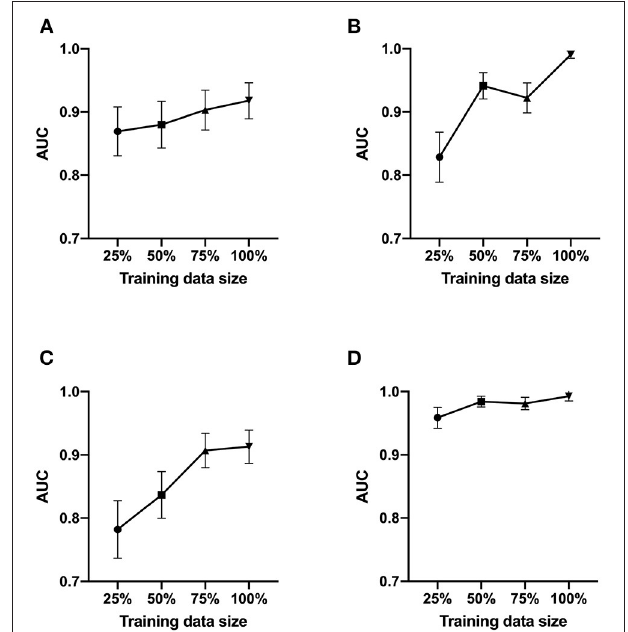
FIGURE 2 | ROC curve. ROC analysis was performed at a sample size of 25, 50, 75, and 100%. (A) ROC analysis for atelectasis. (B) for pleural effusion. (C) for pneumonia. (D) for no emergency.